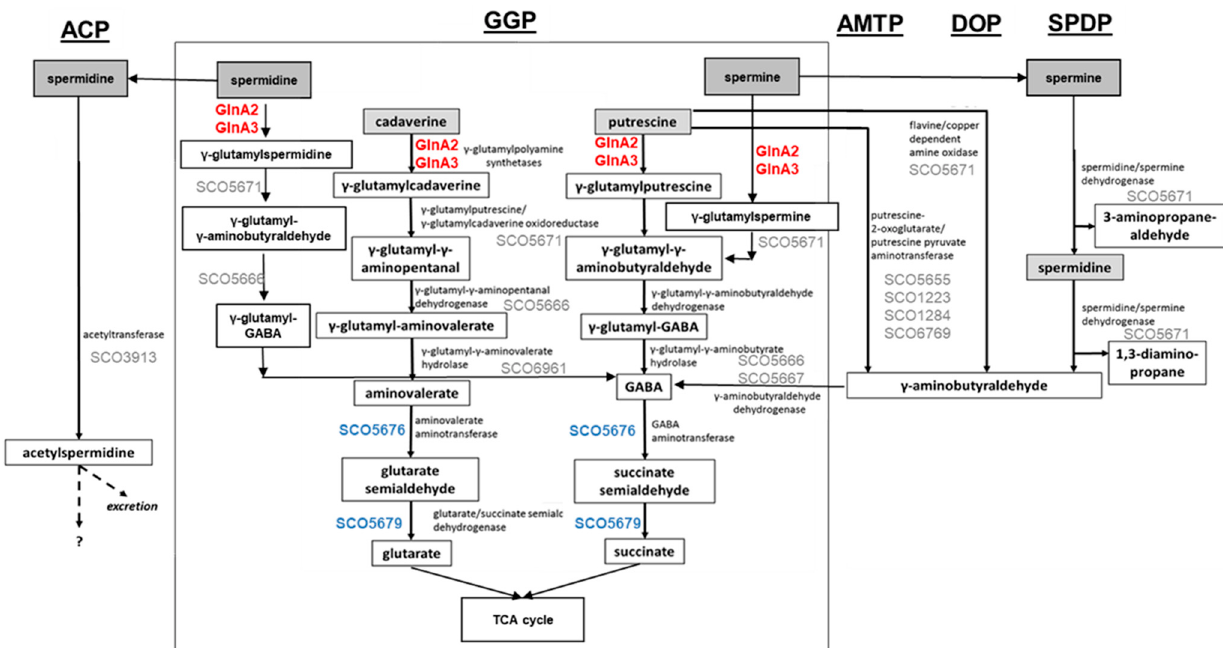
Figure 1. Combined model of polyamine utilization pathways within prokaryotes and in S. coelicolor based on published studies [2,4,12–15,17]. GGP, gamma-glutamylation pathway; AMTP, aminotransferase pathway; DOP, direct oxidation pathway; SPDP, spermine/spermidine dehydrogenase pathway; ACP, acetylation pathway. Dashed arrows represent predicted metabolic pathways. Enzymes in red: confirmed gamma-glutamylpolyamine synthetases in S. coelicolor . Proteins in blue: confirmed role in polyamine utilization in S. coelicolor . Proteins in grey: predicted role in polyamine utilization in S. coelicolor .